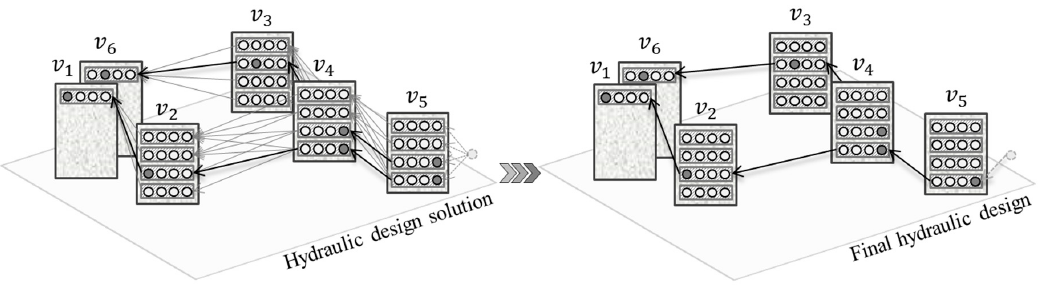
Figure 3. Selection of the definitive hydraulic design, eliminating double pipes generated from different shortest paths.